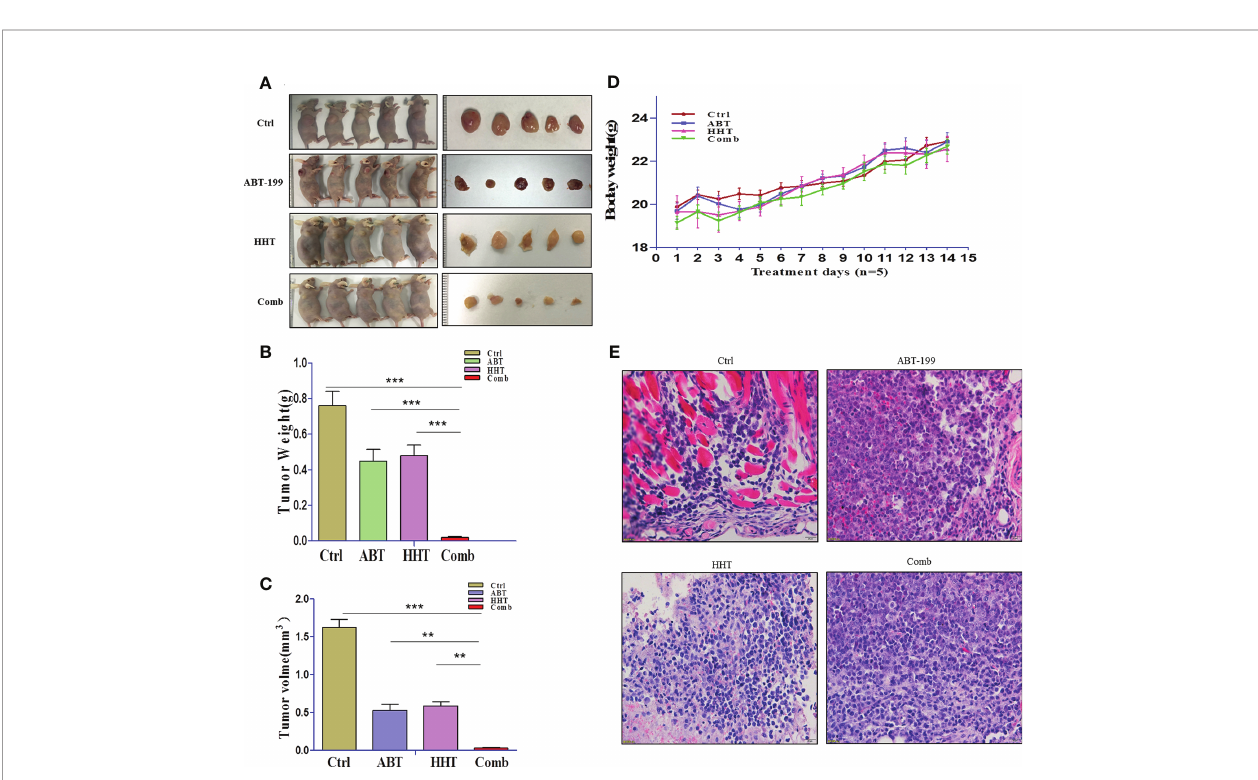
FIGURE 4 | The antitumor potency of ABT-199 combined with HHT was evaluated in OCL-AML3 cell line-derived mouse xenograft models (n = 5 per group). Compared with each agent alone, the combination of ABT-199 with HHT signi fi cantly decreased the tumor burden, including tumor size and weight (A – C) . Mouse body weight was measured every other day. (D) Bone marrow from mice was embedded in paraf fi n and stained with H&E. Scale bar, 25 m m. Data represent the mean±S.D. *P<0.05 vs the cotreatment groups (E) . (*P < 0.05, **P < 0.01, and ***P <